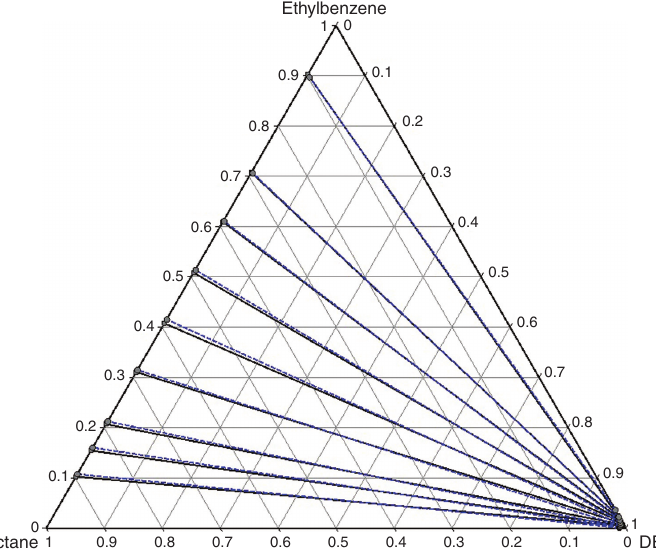
Figure 1: Experimental and calculated (dashed) tie lines for the ternary mixture ethyl benzene+ n -octane+DES1.